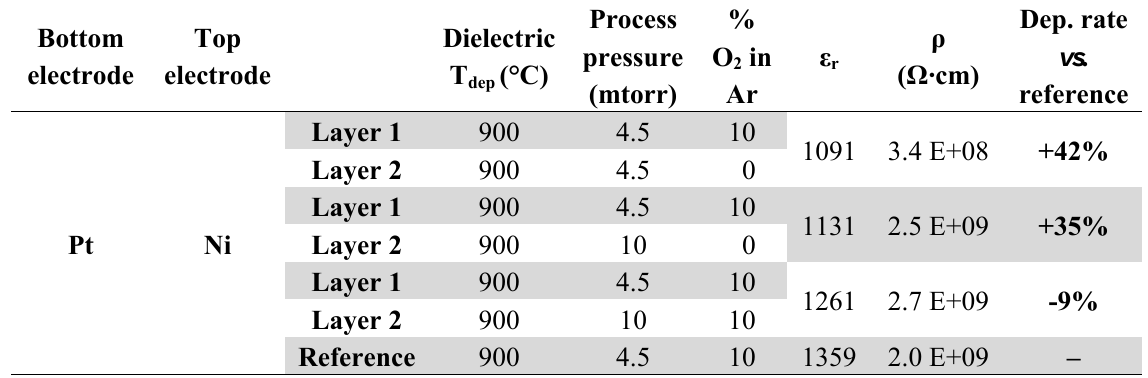
Table 3. Effect of sputtering alternating layers of BCZTO at different process conditions on electrical properties and deposition